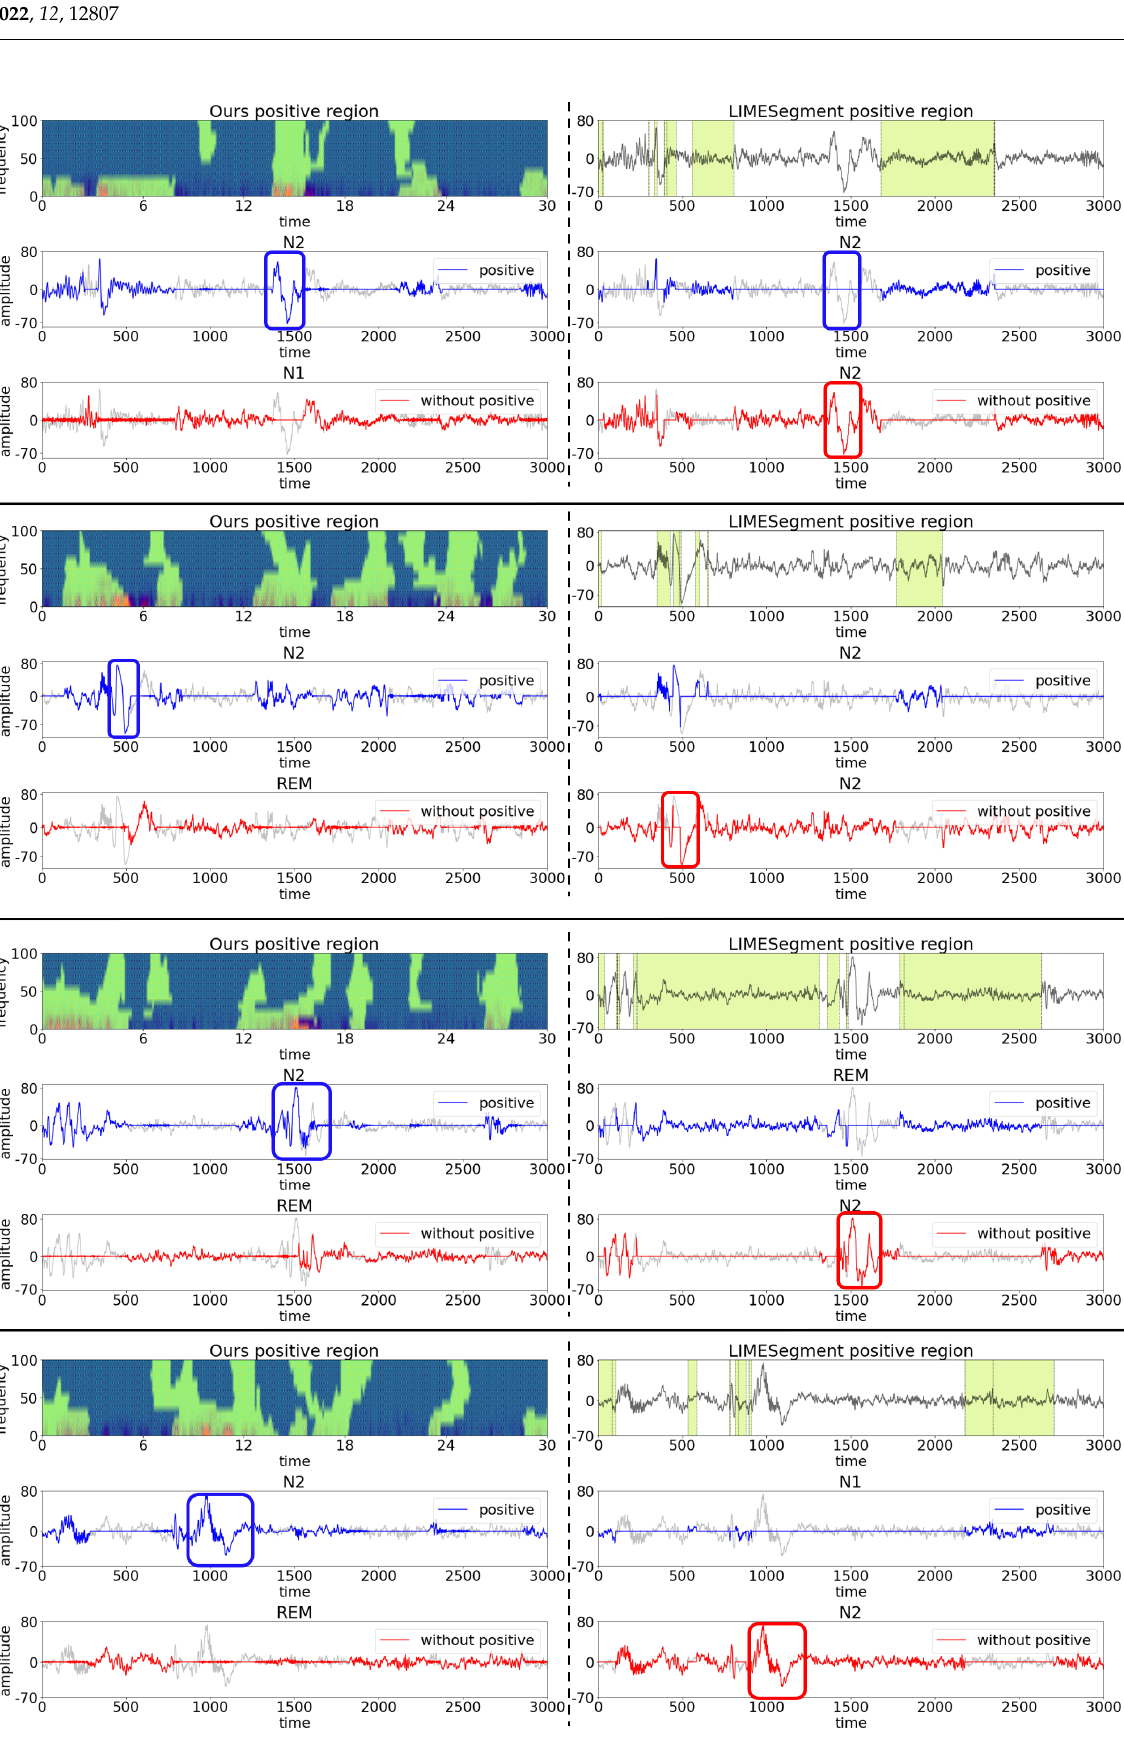
Figure A1. Additional representations obtained by ours and LIMESegment for